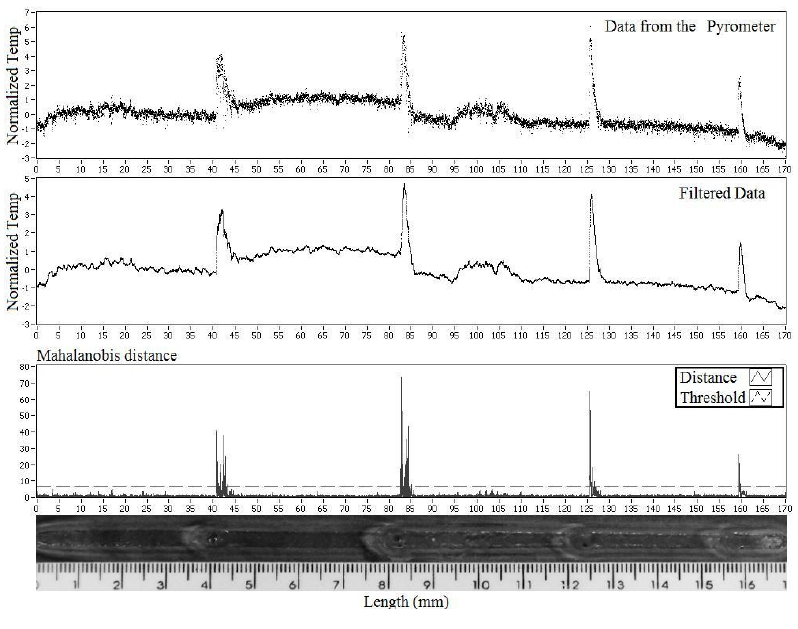
Figure 9. Current Plate with water defects and Mahalanobis